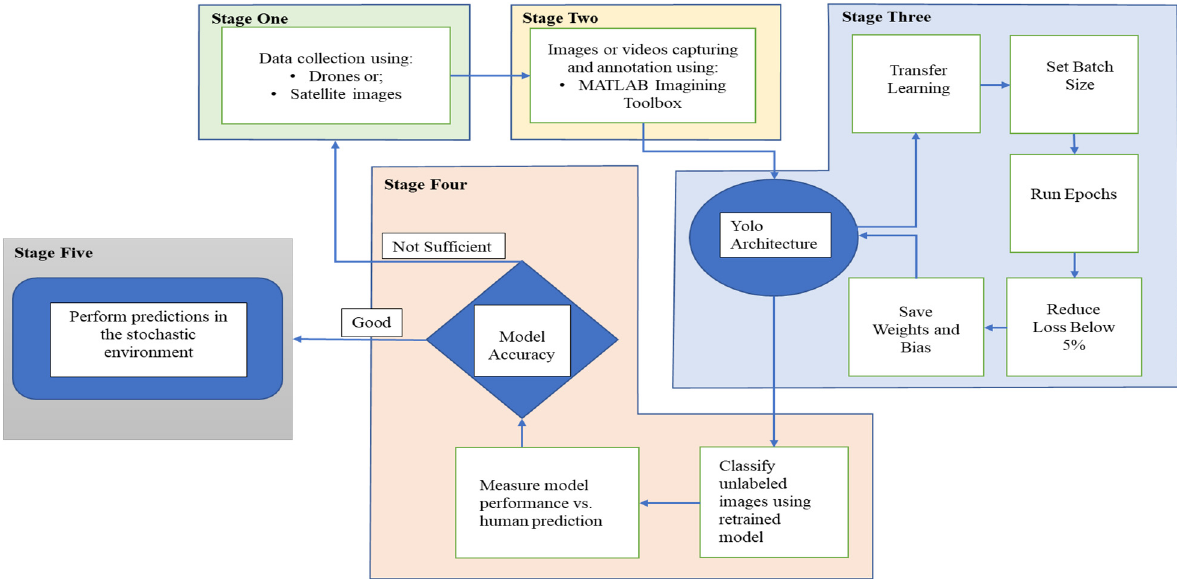
Figure 1. The proposed model flowchart.